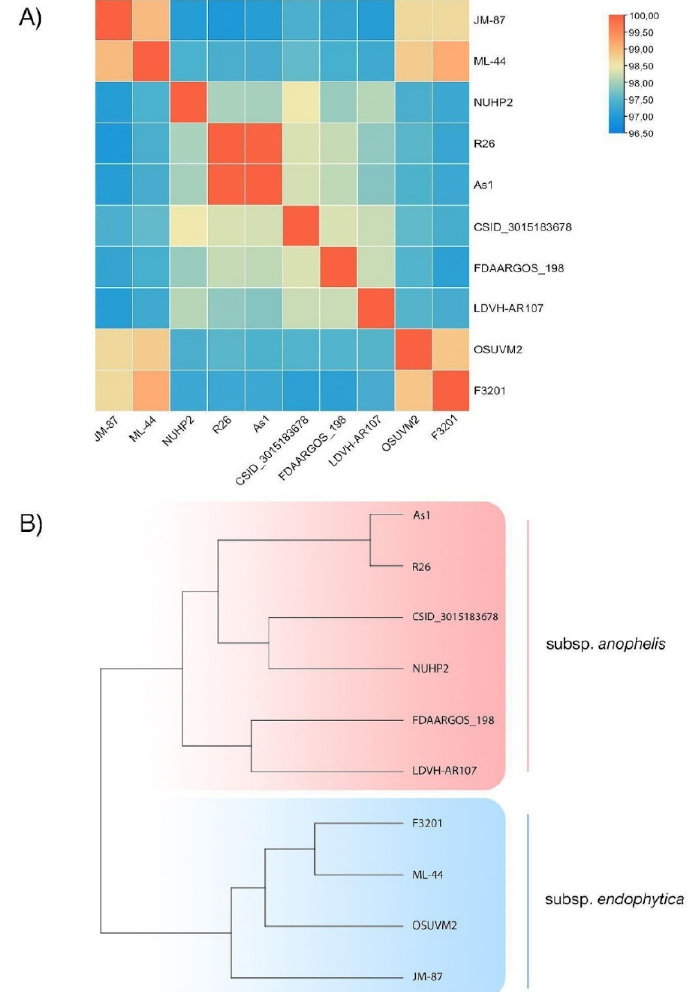
Figure 3. OrthoANI analysis results: ( A ) Heat map based on ANI values among ML-44 strain and other 9 E. anophelis strains; ( B ) Cladogram based on OrthoANI calculations. Table 2. Genome-to-genome distance calculator (GGDC) analysis for ML-44 strain and other related E. anophelis strains.